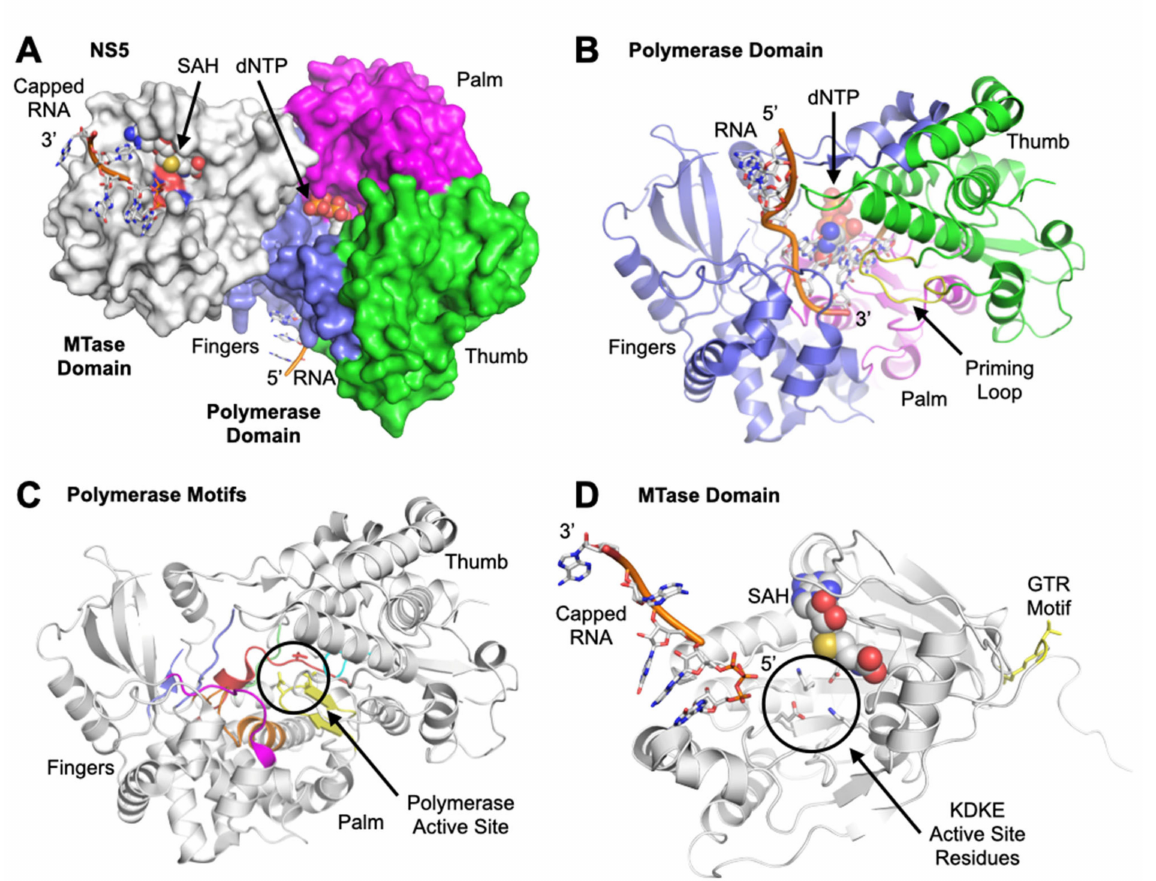
Figure 2. Flavivirus NS5. Dengue structure 5CCV [48] was used to model NS5. ( A ) View of entire NS5 including MTase (white) and RdRP, which is colored by domain. The thumb is green, priming loop yellow, palm pink, and fingers blue. The RNA modeled in the RdRP was manually superimposed using polio RdRP structure 3OLB [49]; the nucleotide is shown in sphere representation. The active site residues exposed on the surface of the MTase are colored by atom type (oxygen, blue; nitrogen, red) while the RdRP active site is not visible in this view. The SAH bound in the SAM binding domain of MTase are shown as spheres. The capped RNA was modeled from Dengue MTase structure 2XBM [50] by aligning the MTase domain to that of the 5CCV structure. ( B ) open view of the RdRP active site containing a newly added CTP (shown as spheres). The RNA backbone is colored orange and the bases are shown as sticks, with carbon atoms colored white, oxygen red, and nitrogen blue. ( C ) RdRP shown in the same orientation as in B, but colored by sequence motif: Motif A is red, B orange, C yellow, D lime, E cyan, F slate blue, and G magenta. The active site aspartates are shown as yellow and red sticks. ( D ) View of the MTase containing the active site, bound SAM shown as spheres and capped RNA shown as in the RdRP. Highly conserved GTR residues are shown in yellow sticks, and active site KDKE residues are shown as sticks colored by atom type as in